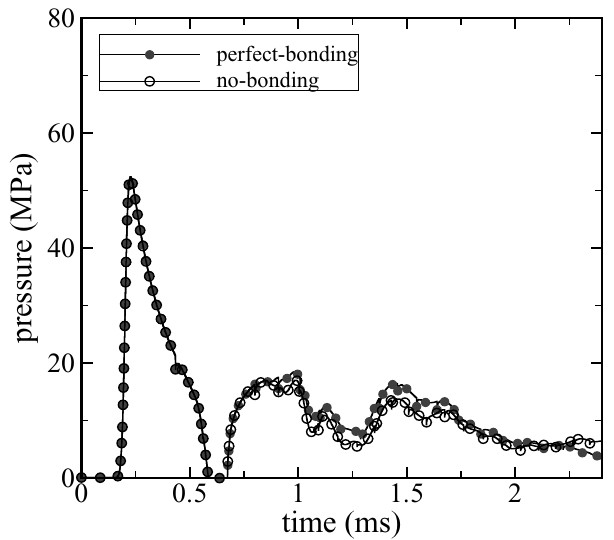
Fig. 4. Comparison of the front face pressure history at mid-span between the perfect- and no-bonding sandwich plates with clamped ends.